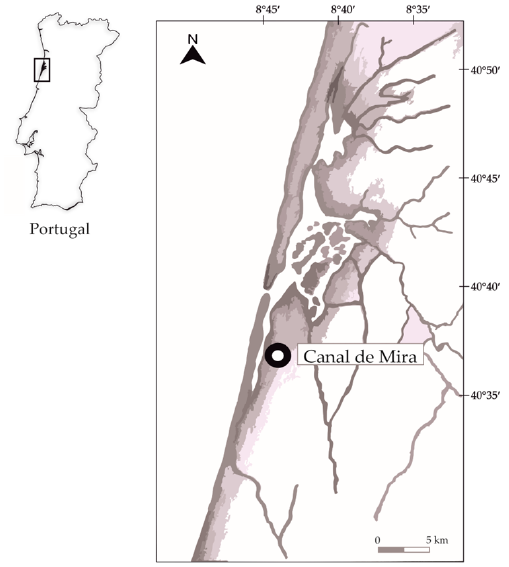
Figure 1. Schematic figure representing the Canal de Mira arm of Ria de Aveiro. This channel is an elongated and shallow arm, 25 km long, that runs south-southwest, parallel to the west Portuguese coastline.